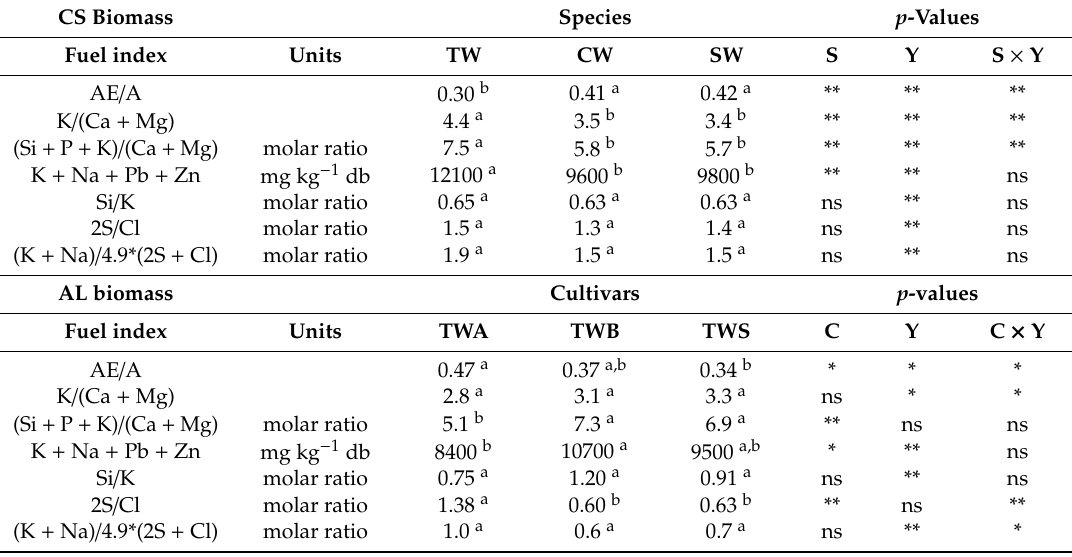
S: species; C: cultivar; Y: year; df: degrees of freedom; ** p -value < 0.01; * p -value = 0.01–0.05; ns: p -value > 0.05, according to Fisher´s tests (order 2 ANOVA). Di ff erent letters indicate significant di ff erent means between